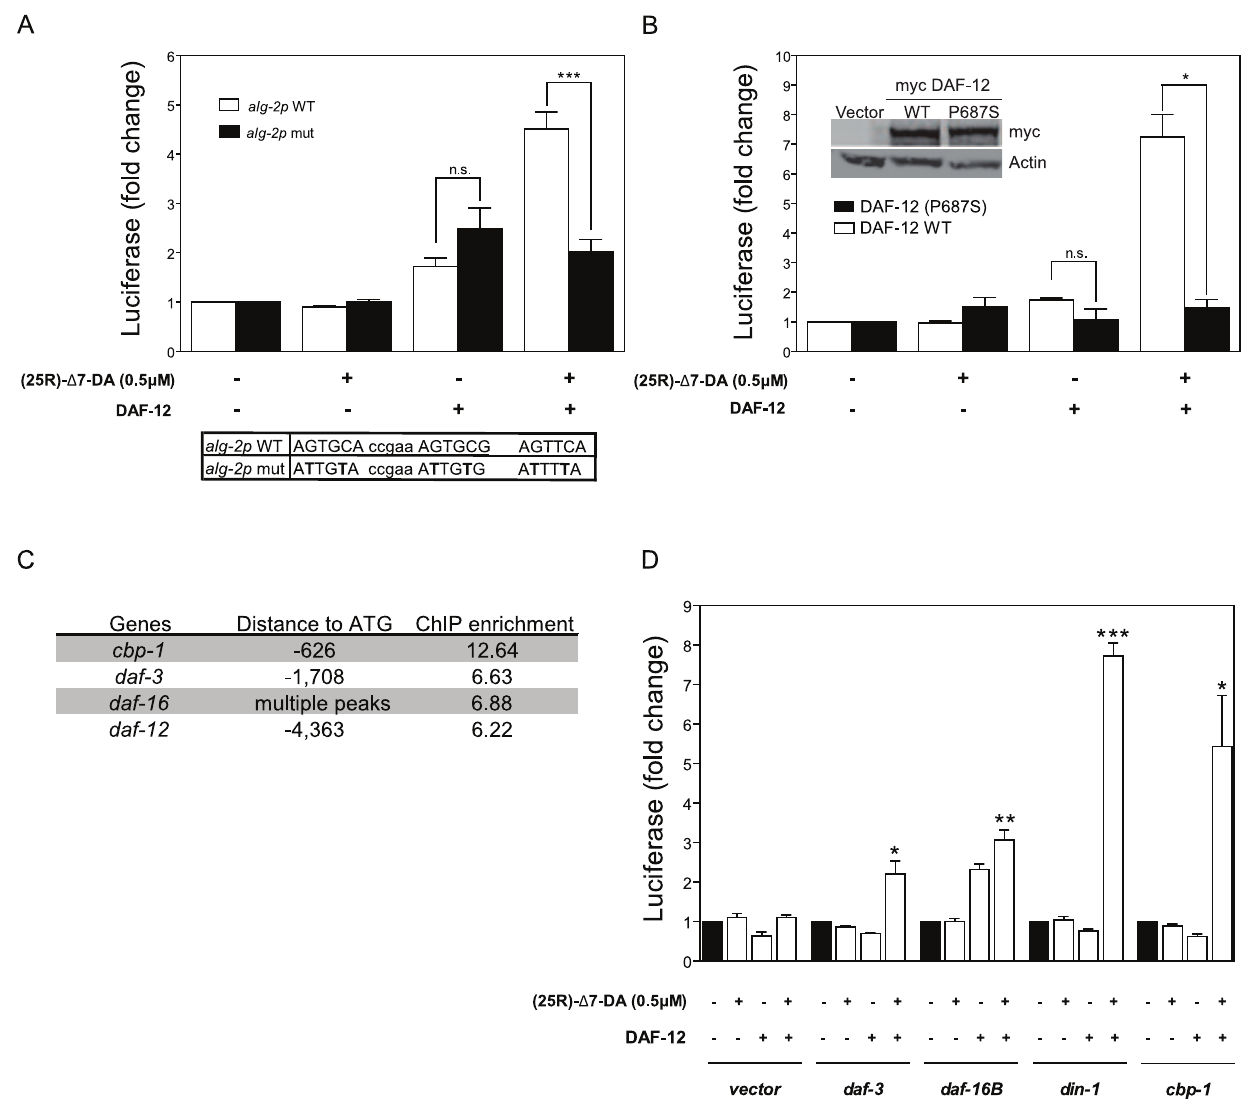
Figure 3. DAF-12 activates target genes in cells. ( A ) HEK cells were transfected with either pCMV-myc-DAF-12 or pCMV-myc vector, along with pGL3-Luc alg-2 promoter and pRL-TK renilla to normalize for transfection efficiency. Cells were stimulated for 16 hr with 0.5 m M (25R)- D 7–DA or DMSO as a control. Mutations within DR5 domain are indicated (box). ( B ) Luciferase activity was measured for pGL3-Luc let-70/atg-7 promoter as in (A), with either DAF-12 or DAF-12 (P687S) expression plasmids. ( Inset ) Western blot shows similar expression levels of WT and mutant DAF-12 proteins. ( C ) Binding sites and ChIP enrichment for DAF-12 relative to ATG within genes involved in transcriptional regulation and dauer formation. ( D ) Promoter regions of corresponding genes were subcloned into pGL3-Luc and luciferase activity was measured as in (A). Bars denote standard error of mean (SEM). P-values were determined by Student’s t-test. * p , 0.05, ** p , 0.01, *** p , 0.001, n.s. (difference is not statistically significant). collected at different developmental stages, and heterochronic DAF-12 mutant unable to promote transcriptional activity gene expression was quantified by RT-qPCR. As seen in (Figure 3B), using NanoString analysis [49]. As shown in Figure 4C, daf-12(0) worms show significant differences in Figure 4D, although all observed differences were not statistically expression when compared to N2. Importantly, DAF-12 can significant, in most cases DAF-12 is necessary for full expression of either repress or activate the same gene depending on the these targets. However, DAF-12 might be involved in repression of lin-28 as its expression is up-regulated in both daf-12 mutants at the developmental stage (i.e. lin-41 at L4 or adult stage). Interestingly, the circadian clock gene lin-42 , which has been suggested to be L3 stage (Figure 4C and 4D). Consistent with this, lin-28 mRNA is important for the molting process [47], is normally repressed by also up-regulated in din-1(dh149) worms (data not shown). Our DAF-12 at the adult stage. This could be necessary to prevent findings point to a role for DAF-12 in regulation of heterochronic extra molting cycles once development is completed. and miRISC gene expression during post-embryonic develop- ment. sites, most of them showed a weak mis-regulation (Figure 4D). To